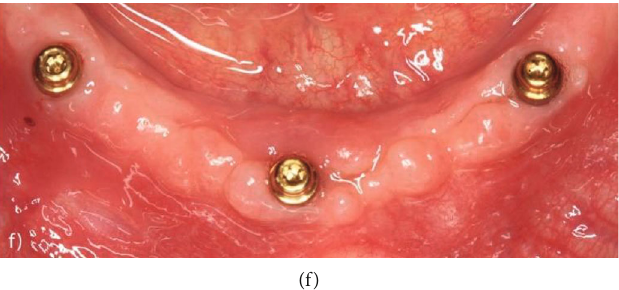
Figure 2: Panoramic X-rays: (a) preoperative, (b) immediately postoperative, and (c) 1 year postoperative; (d) peri-implant healing after 3 months; (e) tissue condition after removal of the healing caps; (f) installation of prosthetic attachment and adaptation of peri-implant tissues around the Equator